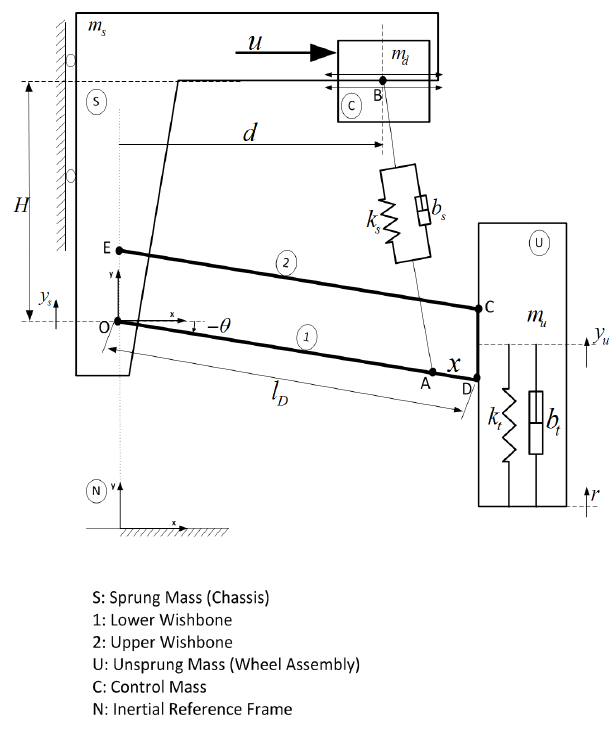
Figure 3. Quarter Car